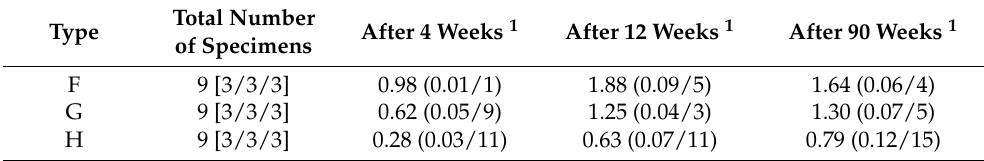
Table 2. Mortar flexural strength f m.flex in MPa.